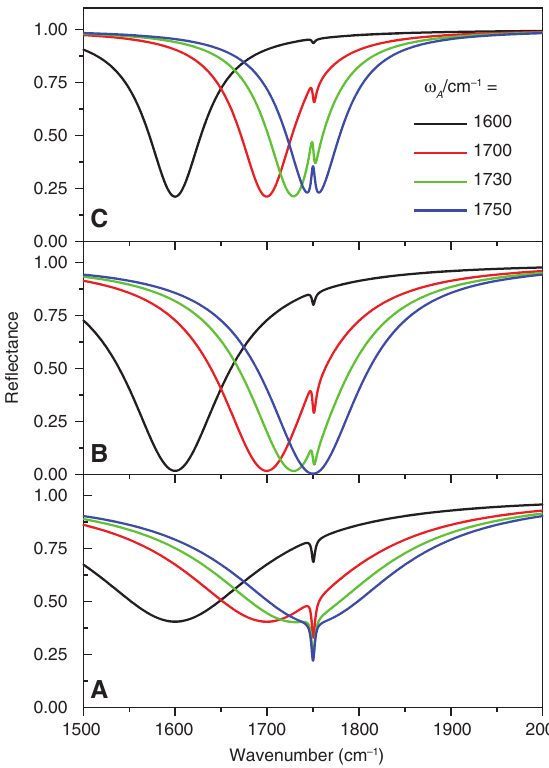
Figure 1: Reflectance due to the coupled system plasmon-molecular vibration for varying resonance frequencies of the plasmon ω (1600, 1700, 1730, and 1750 cm −1 ) and ω = 5 cm −1 . (A) Depicts an overcoupled situation with γ μ P whereas the ratio γ the interaction with the dark oscillator (B) and γ undercoupling